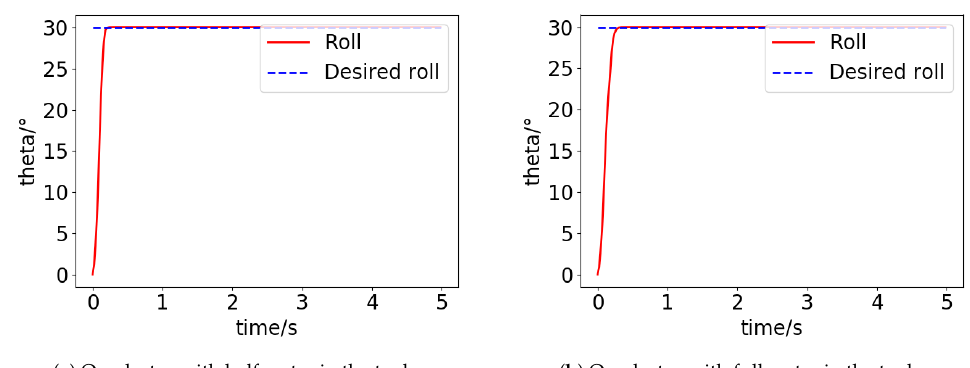
Figure 8. Step response performance along the roll